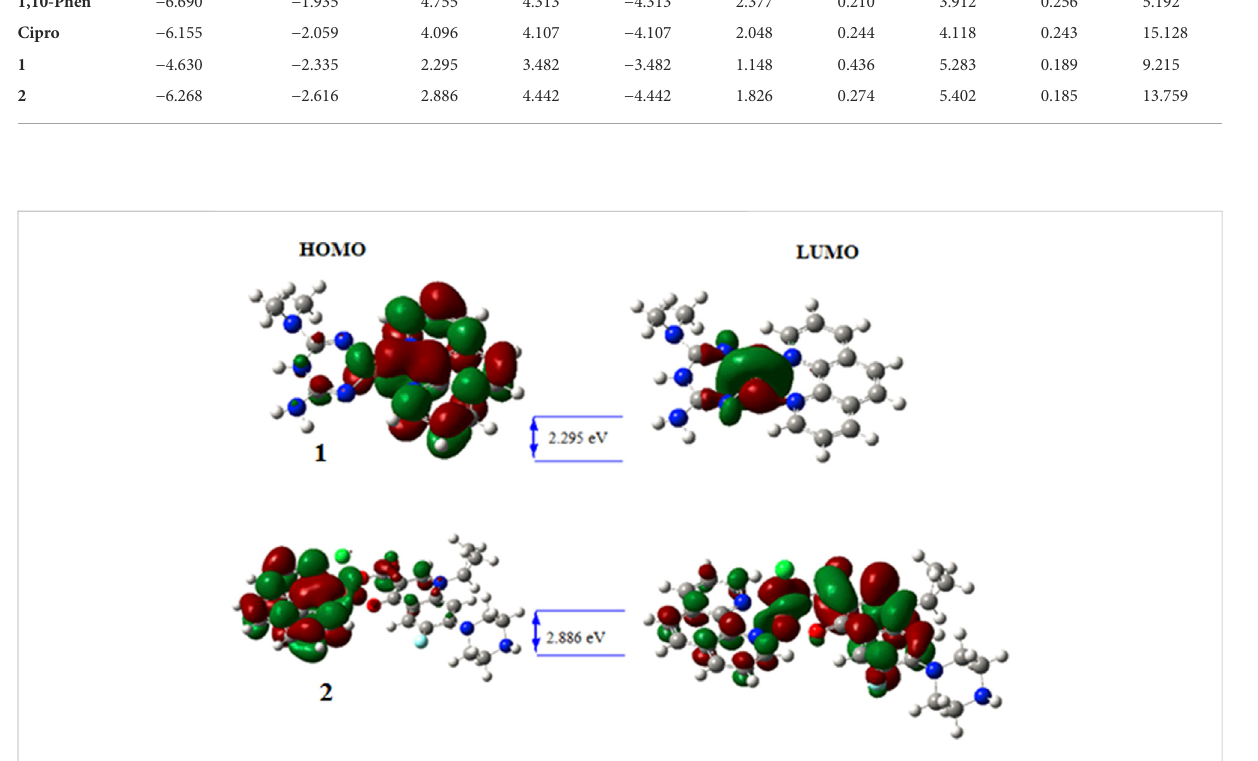
TABLE 3 Quantum chemical descriptor analysis of the ligands and the synthesized metal complexes. CPD HOMO LUMO Nu Dipole Met